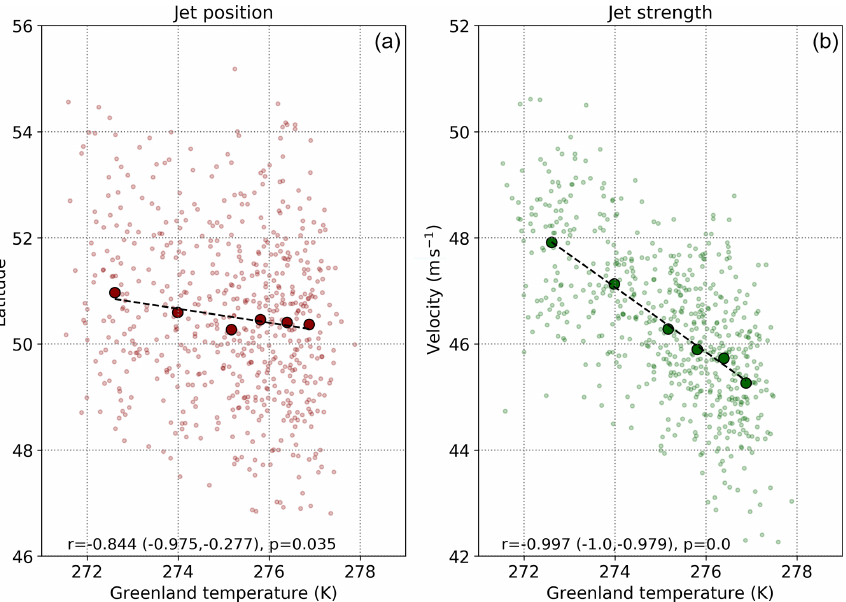
Figure 7. The relationships between the JJA-mean Greenland (55–85 ◦ N, 280–350 ◦ E) 2m air temperature and the latitude (a) and mag- nitude (b) of maximum 300hPa winds across the North Atlantic. As in Fig. 4, correlations, best-fit lines, and p values are calculated with respect to the overall means of each time slice (indicated by large, outlined dots). The smaller dots represent the seasonal-mean values for each of the 100 years of each time